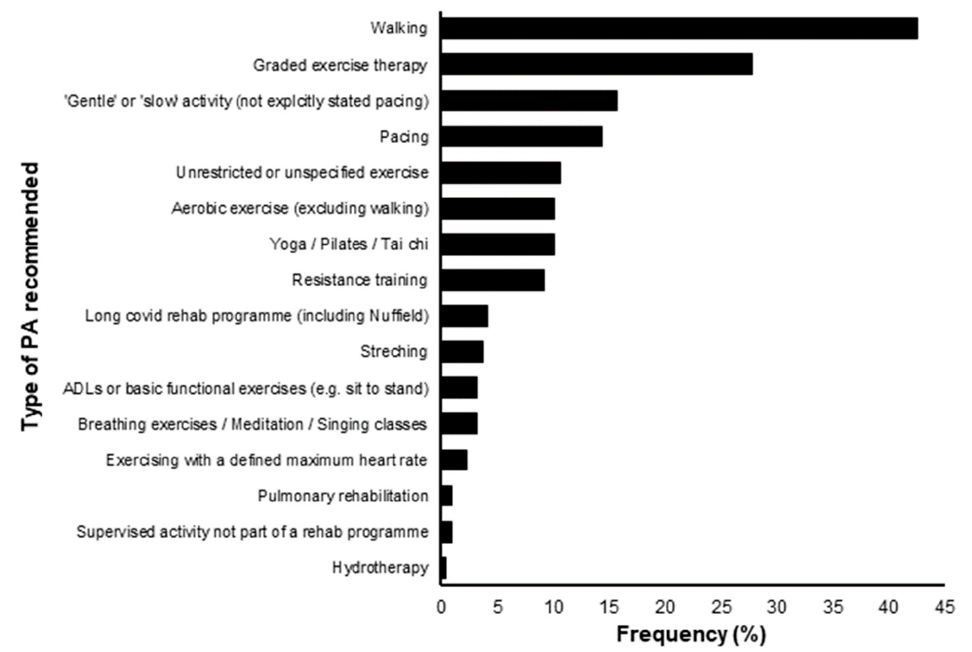
Figure 5. The frequency (%) of which different types of physical activity (PA) were recommended to participants by healthcare professionals in a sample of 216.